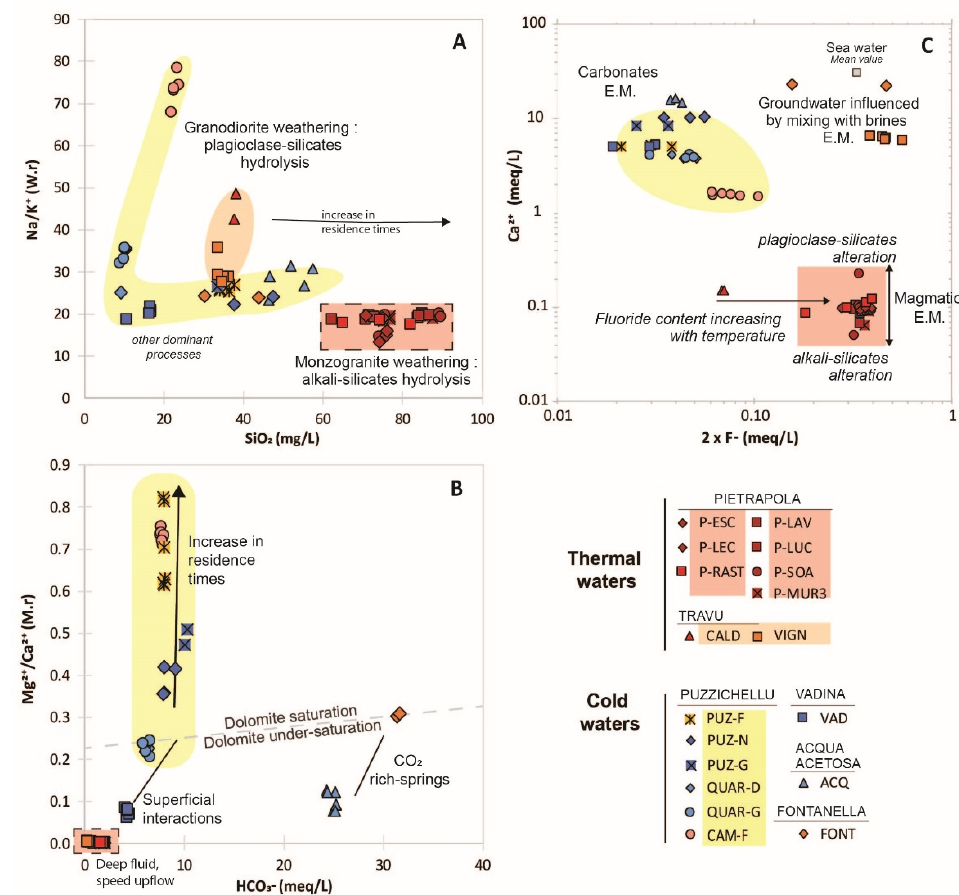
Figure 5. Ions scatter diagram displaying some major ion content or ratio (Na/K, SiO 2 , F, Mg/Ca, Ca and HCO 3 ) associated with trace elements (Li, As, B, Rb/Sr ratio), W.r.: weight ratio. The spring group of Pietrapola is displayed in red background while Puzzichellu is displayed in yellow background and the Travu River Valley in orange background. The ( A ) plot discriminates the Na + and K + content according to granitoid type; the ( B ) plot illustrates the shallow influence at the origin of HCO 3 − , Mg 2+ and Ca 2+ content; the ( C ) plot corresponds to fluorite weathering in hydrothermal waters.